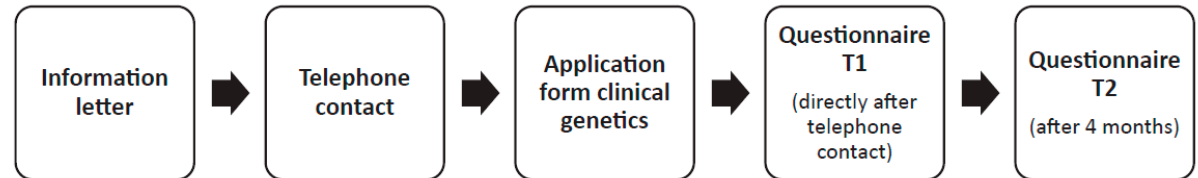
Figure 1. A schematic overview of the (re-)contact approach in idiopathic pulmonary arterial hypertension (iPAH) patients and pulmonary veno-occlusive (PVOD) patients. All iPAH/PVOD patients in our cohort who were not previously genetically tested (CONTACT group) or who tested negative on prior analysis of the BMPR2 and SMAD9 genes (Re-CONTACT group) were (re-)contacted for (additional) genetic testing.